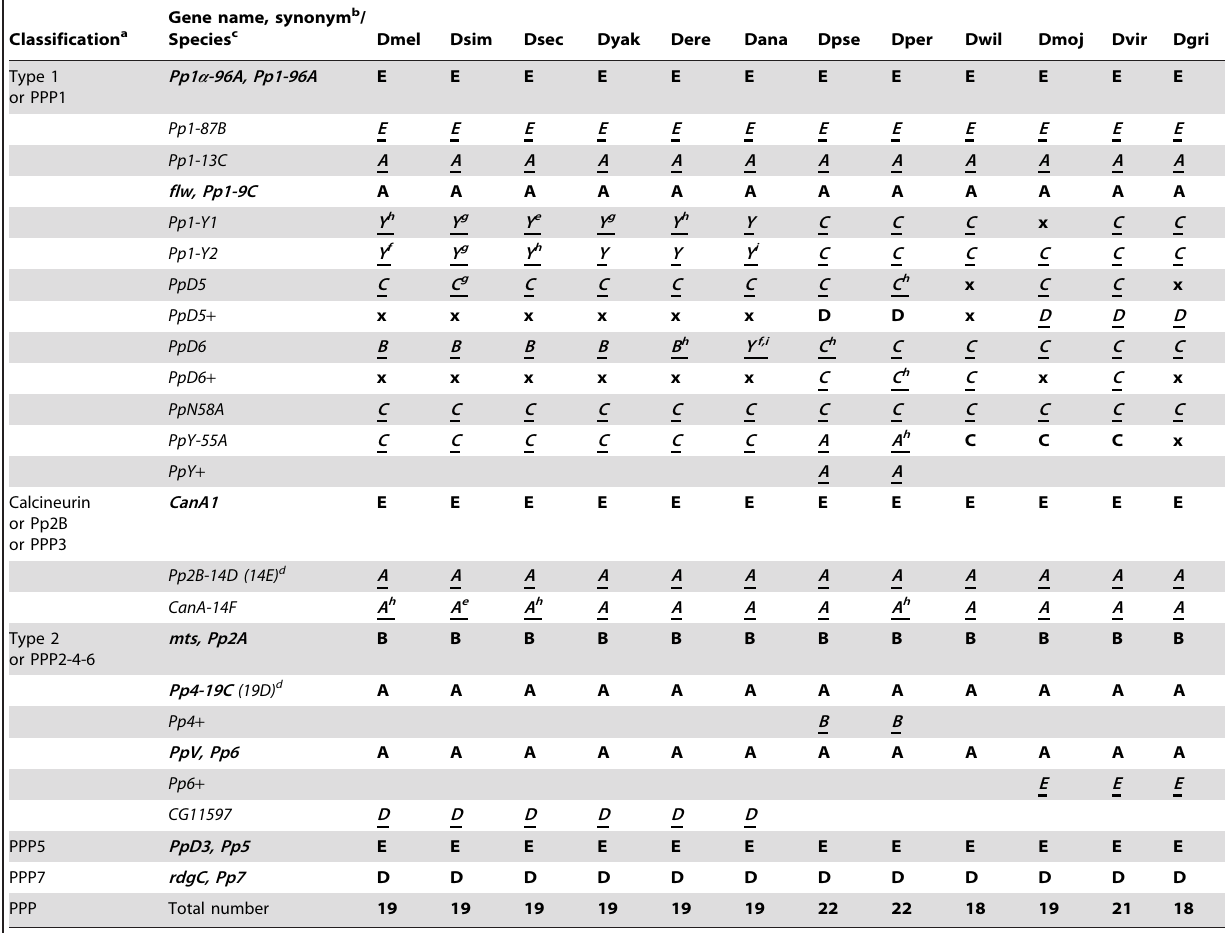
Gene name, synonym b / Species